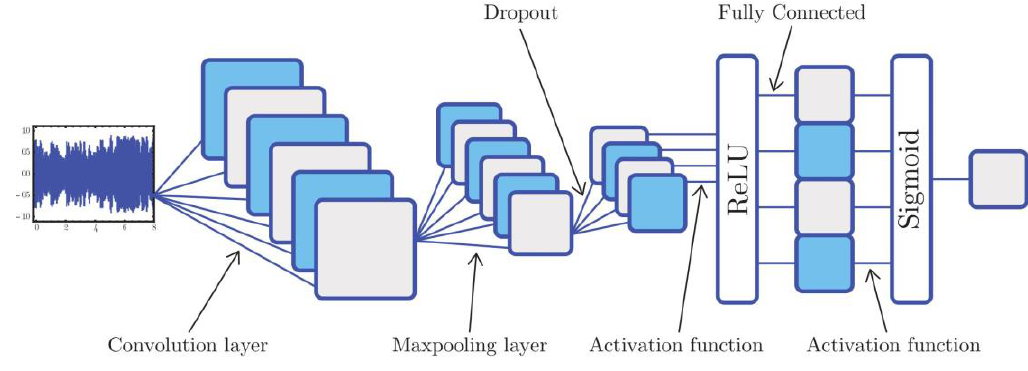
Figure 6. 1D-CNN structure.